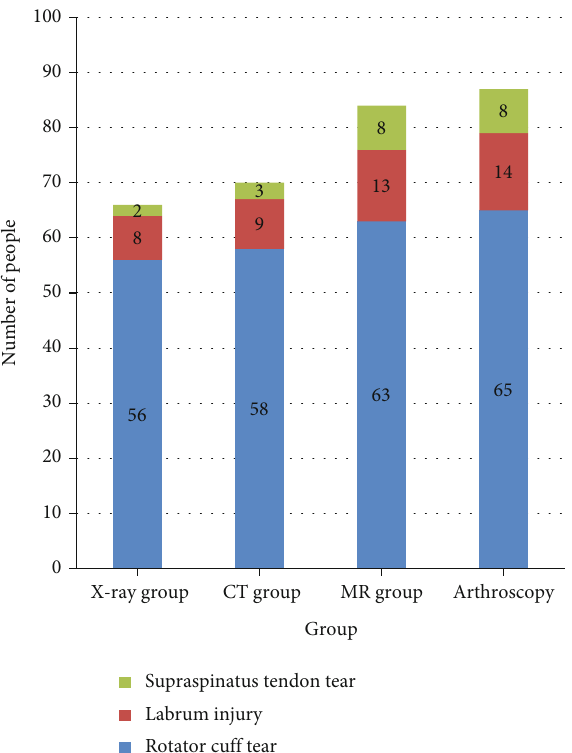
Figure 5: Comparison of the number of patients